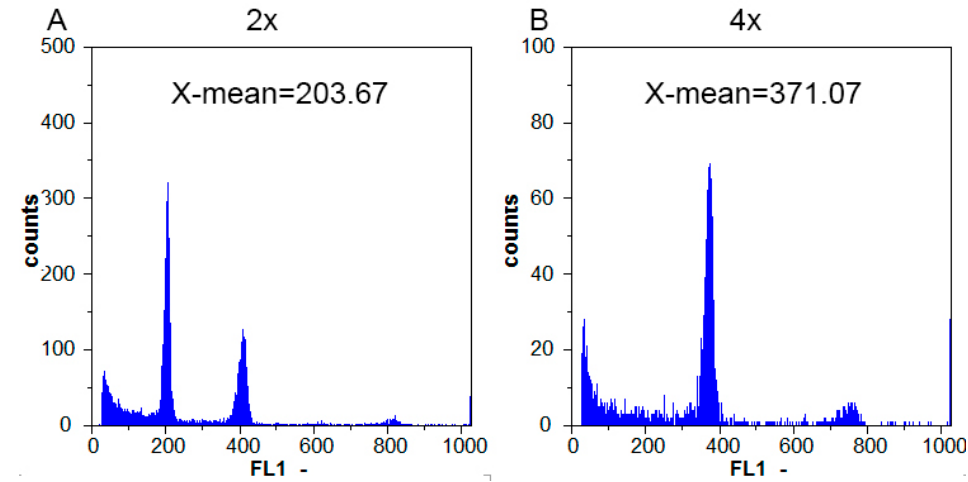
Figure 3 . Polyploidy detection through flow cytometry. The DNA ploidy level of tetraploid watermelon ( B , E46, 2×) was evaluated based on the DNA ploidy level of diploid watermelon ( A , E46, 4×).